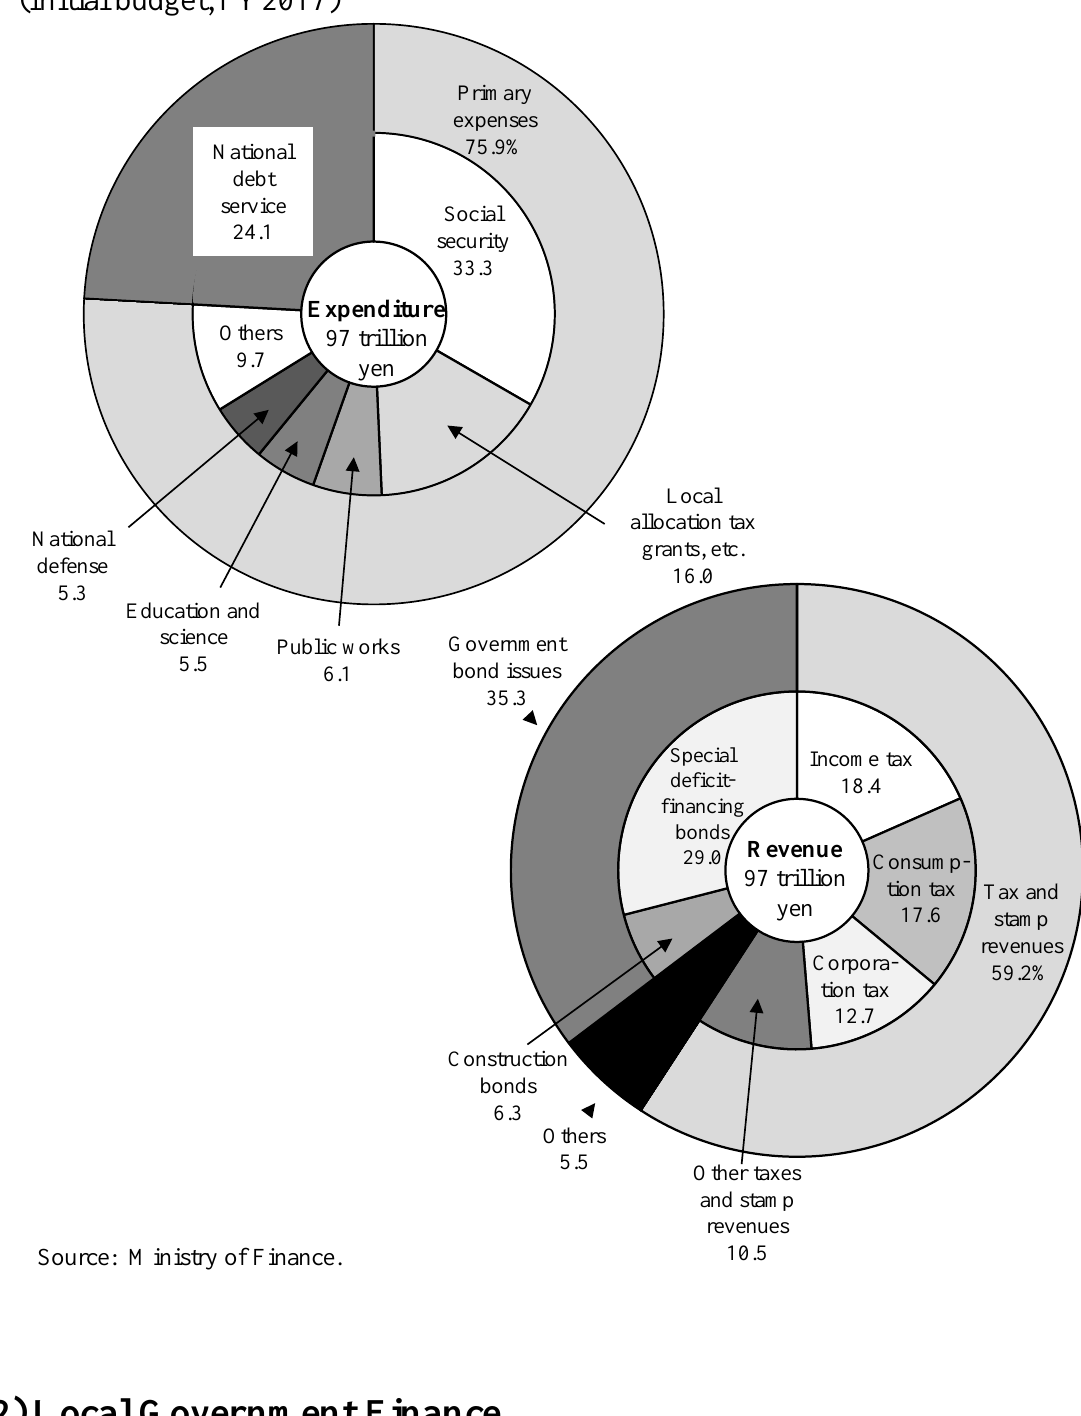
Figure 4.2 Composition of Revenue and Expenditure of General Account Budget (Initial budget,